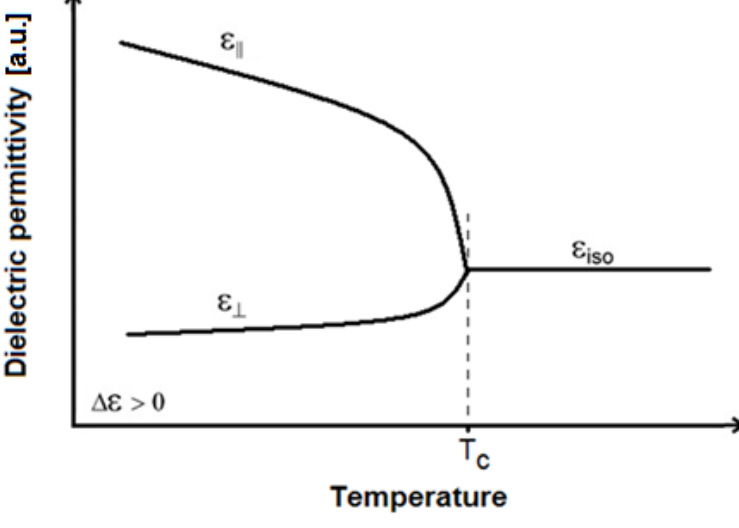
Figure 2. Dependence of dielectric permittivity for a typical nematic liquid crystal on